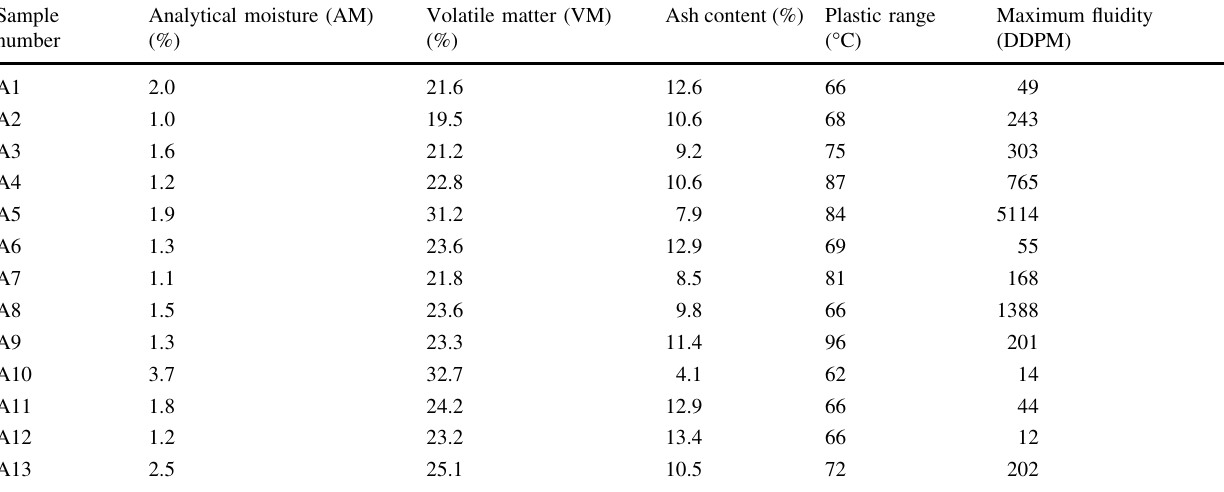
Table 2 Properties of coal blends used for generation of coke samples Sample